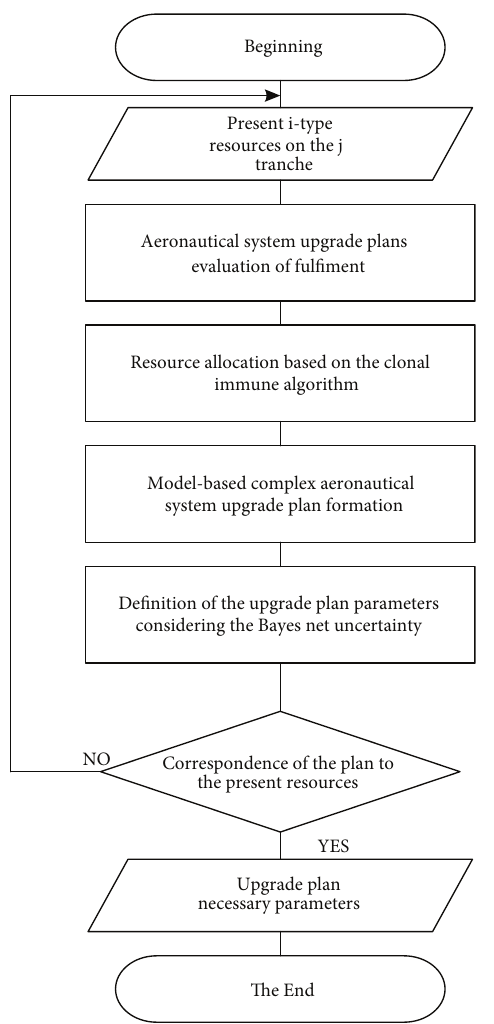
Fig. 4. Hybrid approach algorithm for formation of